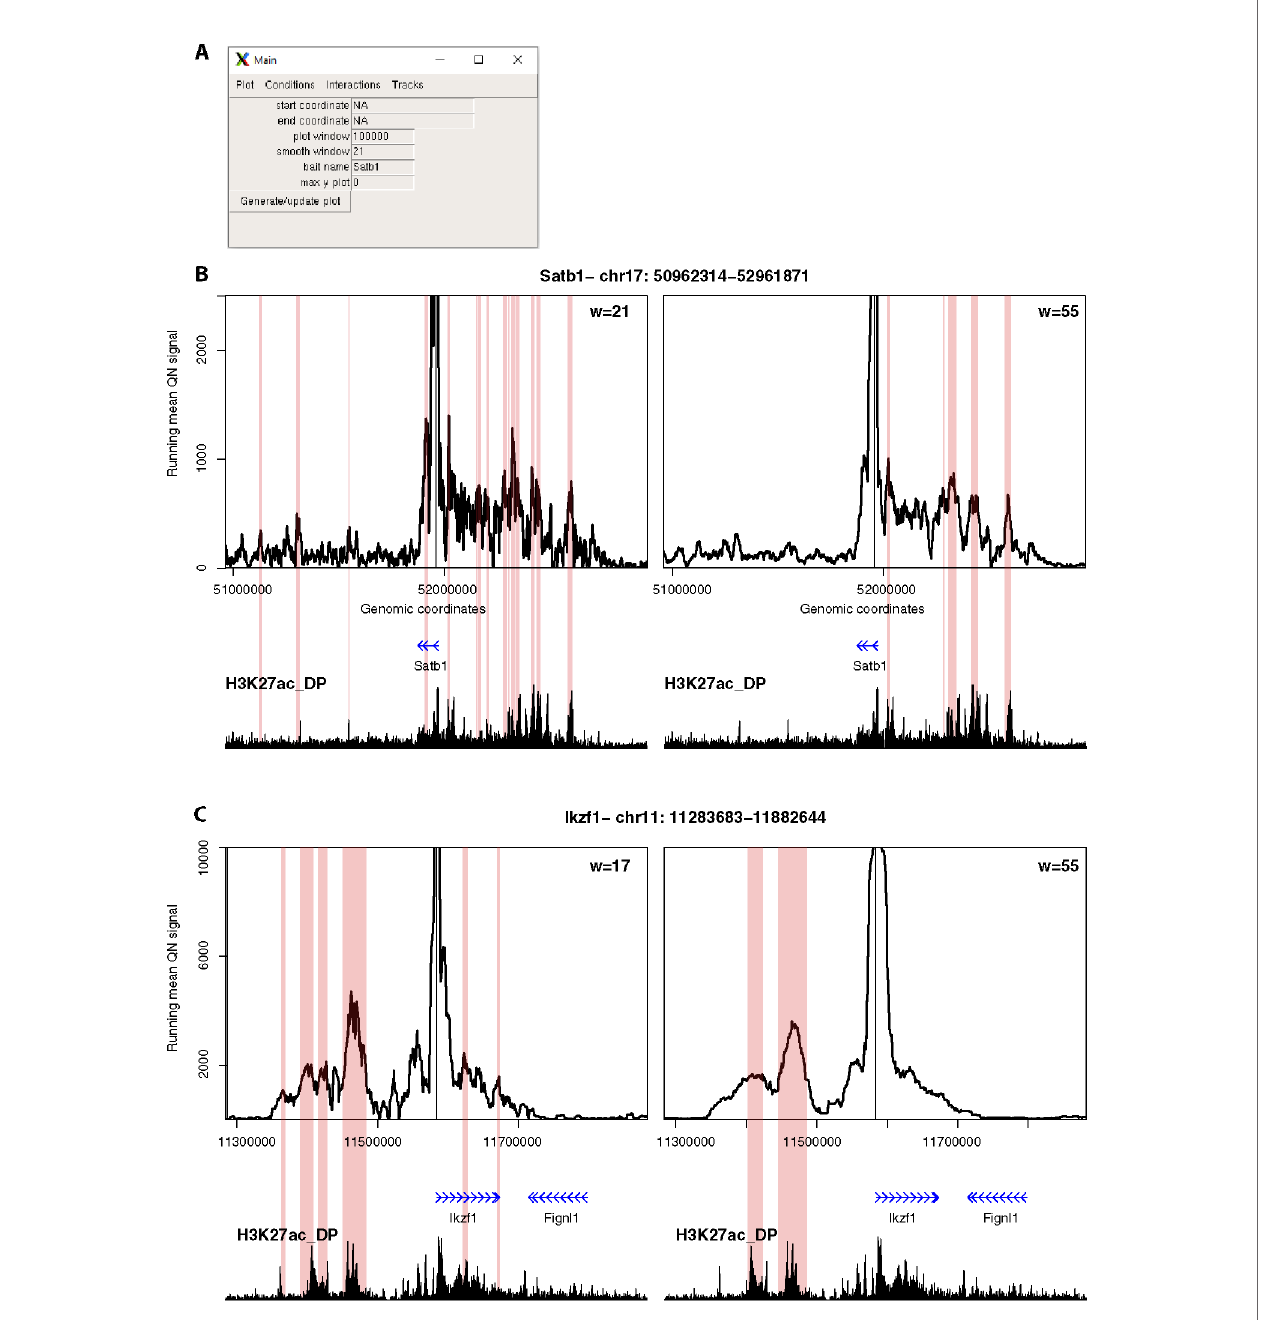
FIGURE 4 | 4See provides fl exibility in running mean window sizes. (A) The main control panel of 4See, including options to set the x-axis ( “ start coordinate, ” “ end coordinate, ” and “ plot window ” ) and y-axis ( “ max y plot ” ) plot limits, to choose a bait name for the plot title ( “ bait name ” ), and to set the running mean window size ( “ smooth window ” ) in number of restriction fragments. (B) 4See plots for a 4C data set in DP thymocytes with the Satb1 gene promoter as bait. Two instances of the same x- and y-axis limits are shown, with a running mean window of 21 (left) or 55 (right) fragments. The position of the Satb1 bait is denoted by a black vertical line, and gene position (blue arrows) and the DP H3K27ac ChIP-seq pro fi le (black) is shown underneath the 4C plots. Pink rectangles denote regions called as interacting by peakC for the equivalent window size as the plot. For the long-range interaction, the smaller window size appears to have more spurious called interactions, less evidently linked to H3K27ac peaks; the link is better seen with greater smoothing from a larger window size. (C) As for (B) , but with the Ikzf1 gene promoter as bait. In this case, the smaller window size (17 fragments) seems to give better resolution of speci fi c interactions with distinct putative enhancers, which are merged into one at larger window